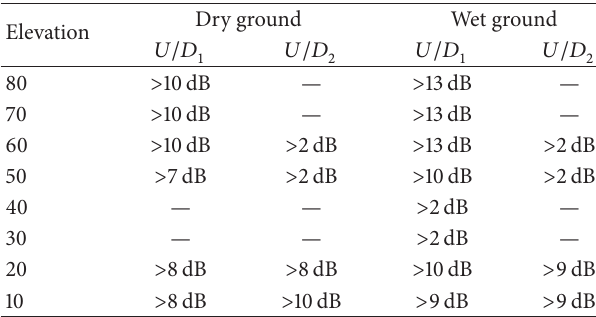
Table 2: The different 𝑈/𝐷 1 and 𝑈/𝐷 2 ratios demand for phase errors below 2mm